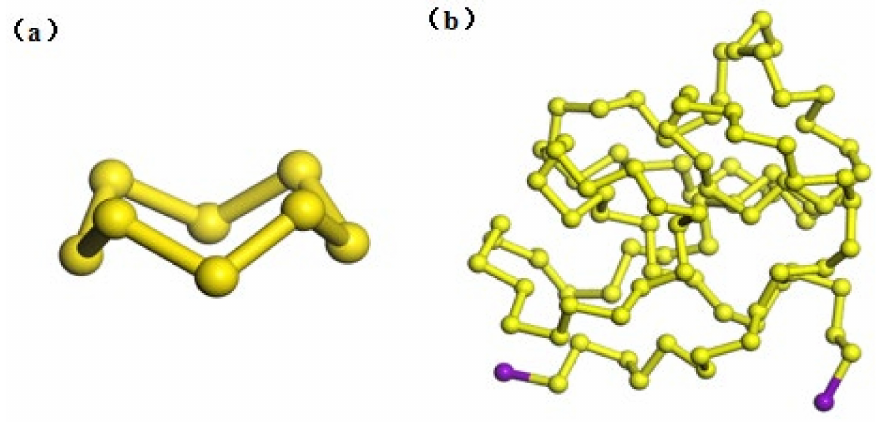
Figure 1. Chemical structure of two single molecules: ( a ) S 8 , ( b )